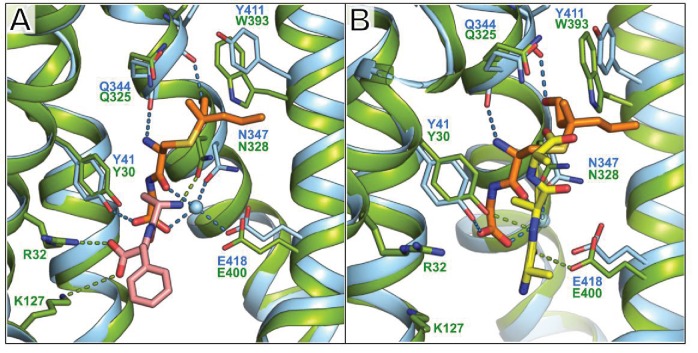
Comparison between the binding position of S-Cys-Gly-3M3SH and the natural di- and tri-peptides co-crystallised with PepTSt.(A) PepTSh (blue) bound with S-Cys-Gly-3M3SH (orange) overlaid with PepTSt (green) bound with L-Ala-L-Phe (pink sticks) (PDB: 4D2C). (B) Equivalent view of PepTSh in (A) but overlaid with the tri-Ala (yellow sticks) co-crystal structure of PepTSt (PDB: 4D2D). The dipeptide moiety of interacts with the conserved E33xxERxYY41 motif with further interactions through the highly conserved Asn347. Backbone mediated interactions from Gln344 and Phe343 help stabilise the substrate in a vertical orientation.